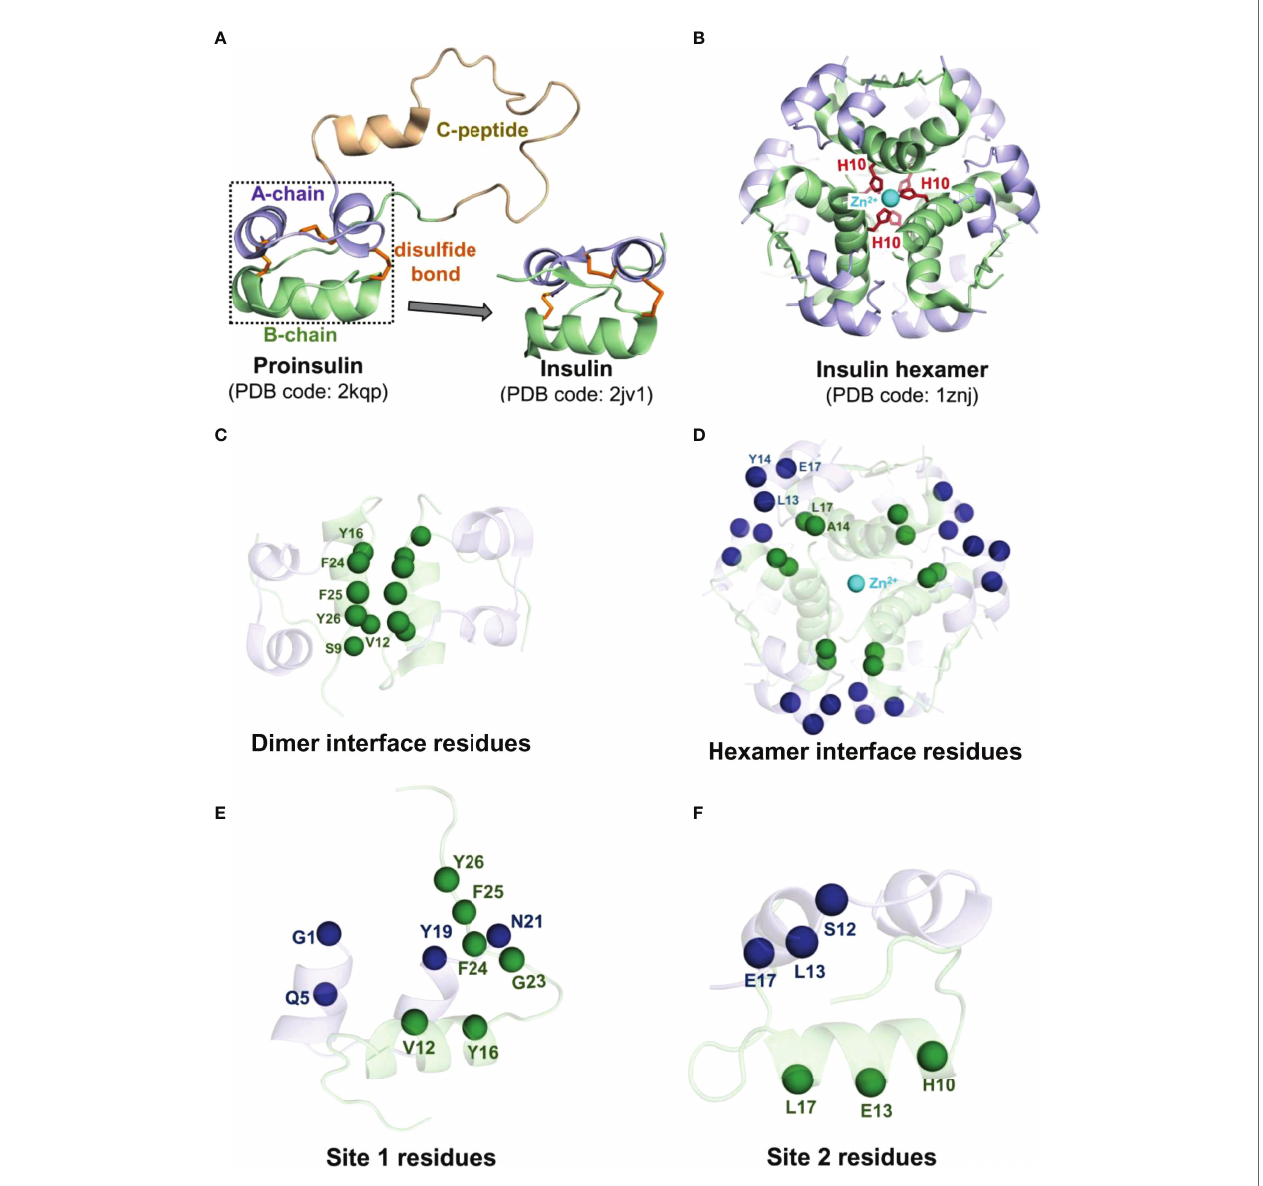
FIGURE 1 | Structural features of the hormone insulin. (A) Shown is the structure of proinsulin consisting of the A-chain (light blue), the B-chain (pale green), and the C-peptide (light brown) connecting the A and B chains. (B) The R 6 insulin hexamer with two zinc ions (cyan spheres) and coordinated histidine residues (red sticks) of the B-chain are depicted. The disul fi de bonds are represented in orange sticks. The C a atoms of the interface residues engaged in the dimer interface (C) and the hexamer interface (D) of each insulin are depicted as spheres in the same color as each chain. The C a atoms of the site 1 (E) and site 2 (F) residues of insulin are depicted as spheres. The residues belonging to the A-chain and the B-chain of insulin are represented in blue and green spheres,